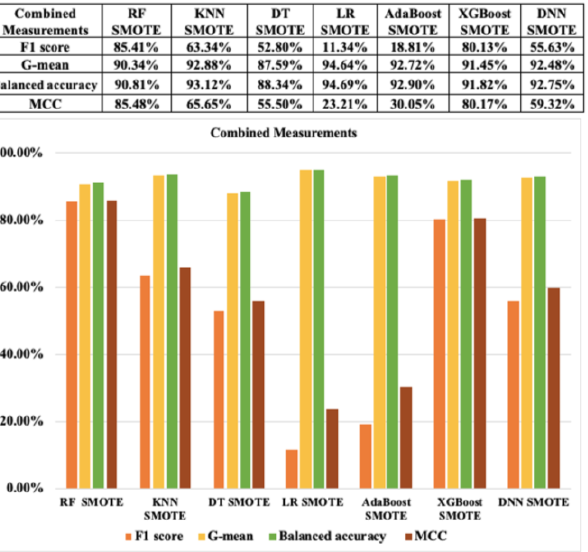
Figure 20. Combined classification performance measurements with SMOTE based on resampling approach 2.